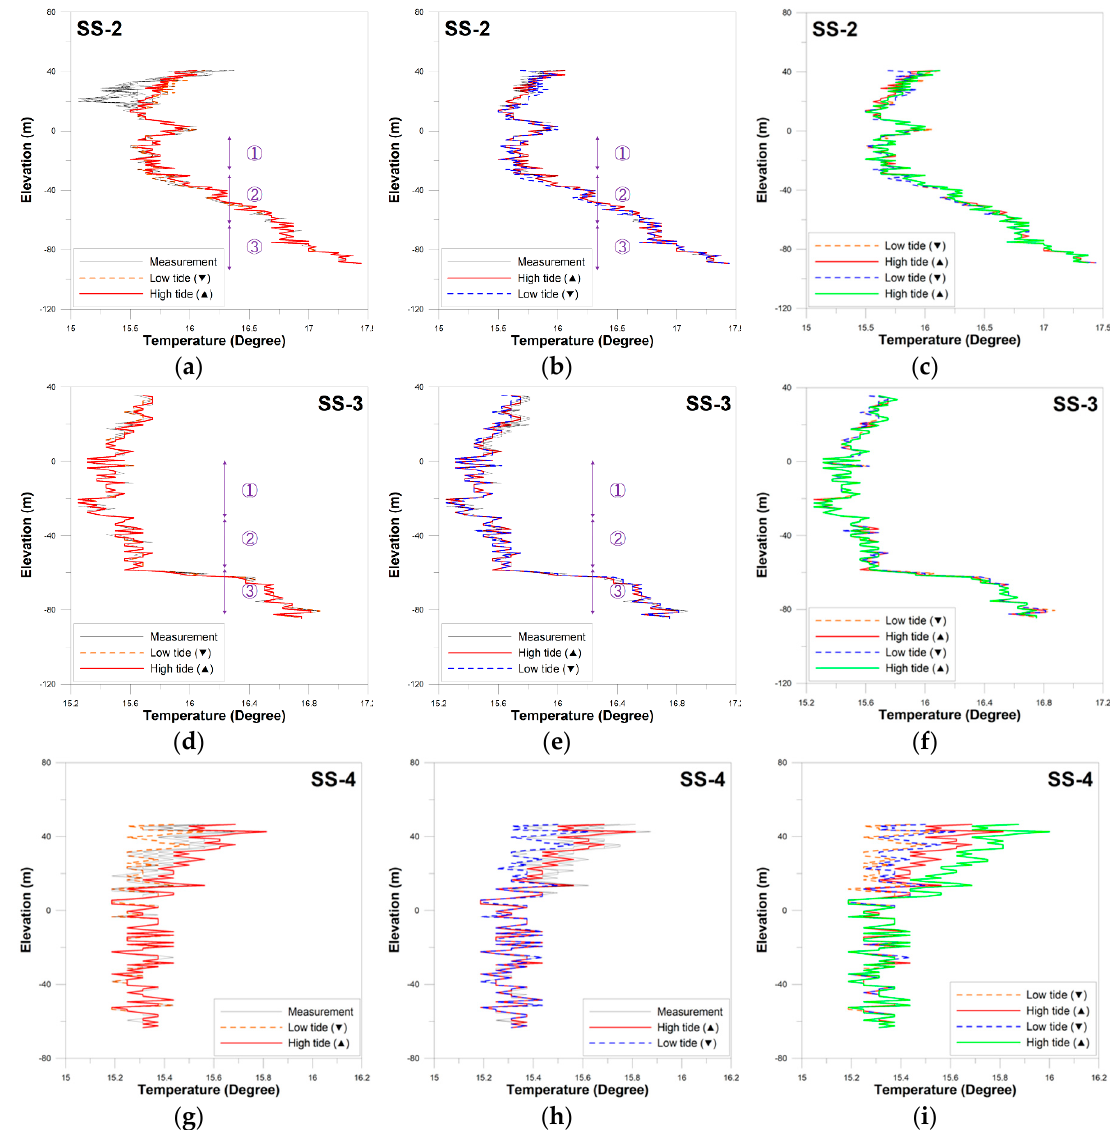
Figure 7. Temperature monitoring results with thermal line sensor in boreholes SS-2, 3, and 4. ( a ) SS-2 temperature during Period A; ( b ) SS-2 temperature during Period B; ( c ) SS-2 temperature at high and low tides; ( d ) SS-3 temperature during Period A; ( e ) SS-3 temperature during Period B; ( f ) SS-3 temperature at high and low tides; ( g ) SS-4 temperature during Period A; ( h ) SS-4 temperature during Period B; ( i ) SS-4 temperature at high and low tides.